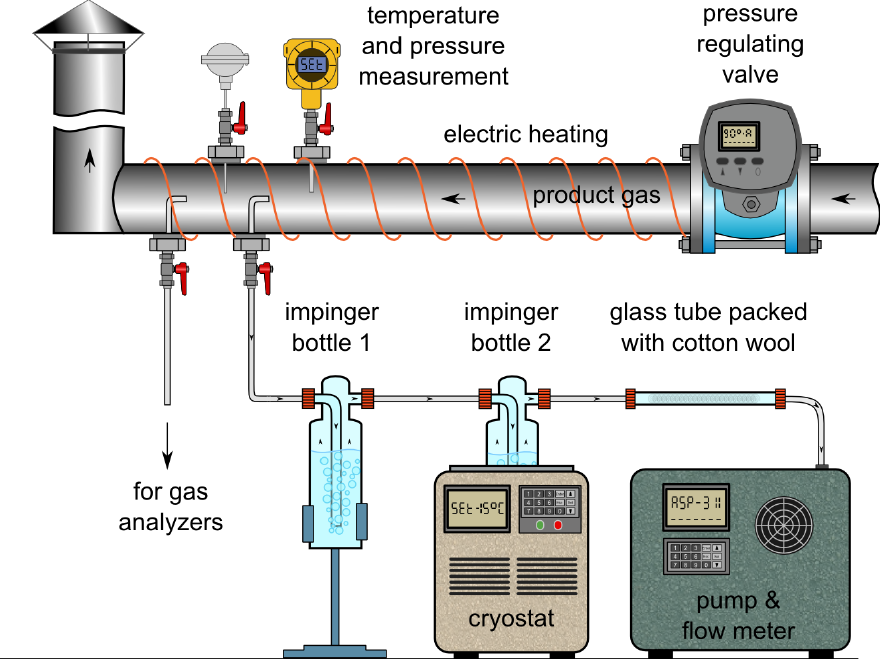
Figure 1. Sampling line integrated with the pressurized gasification reactor.